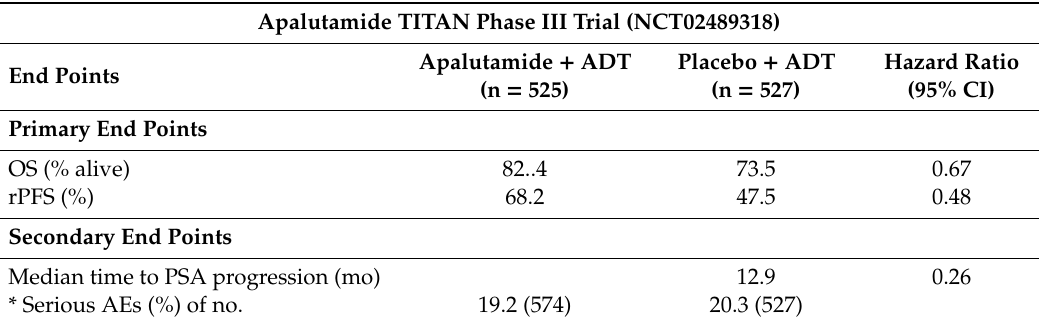
Table 8. Major therapeutic benefits brought by apalutamide based on